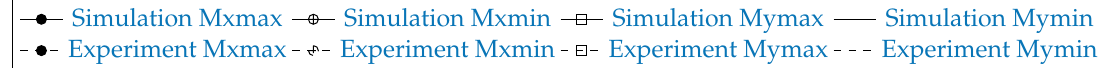
Figure 9. Displacements for all bending load cases. For three positions (1600, 8000 and 15,000 mm) the spar caps were instrumented with additional strain gauge rosettes. The components of a strain gauge rosette ε a , ε b and ε c illustrated in Figure 10 had to be transformed to the strain components in local laminate coordinates (L—longitudinal in 0 ◦ direction; T—transversal in 90 ◦ direction) ε LL , ε TT and ε LT